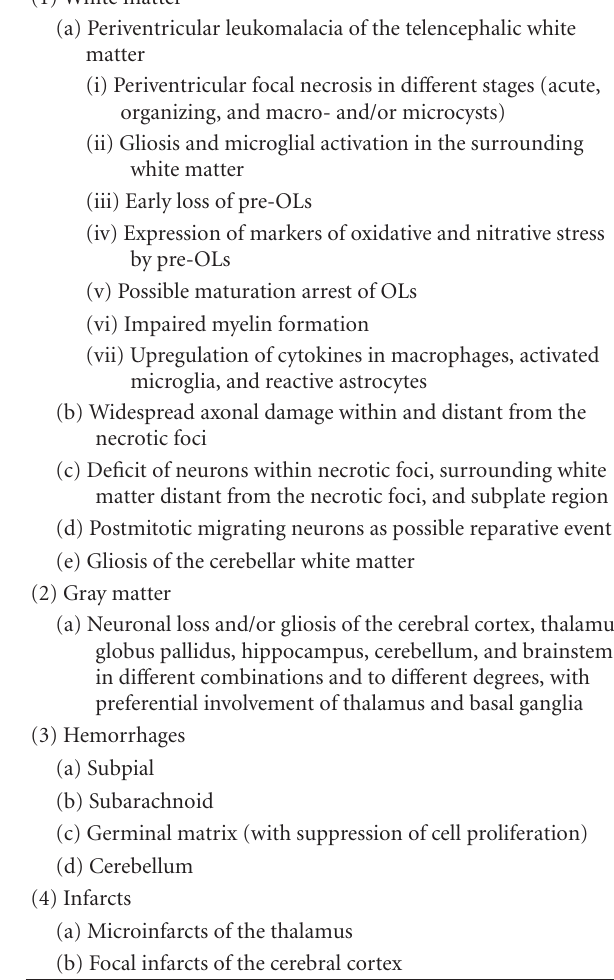
Table 1: Key developmental events in the cerebral white matter, cortex, and subplate region in the last half of human gestation for considering in the design of animal models of the encephalopathy of prematurity.